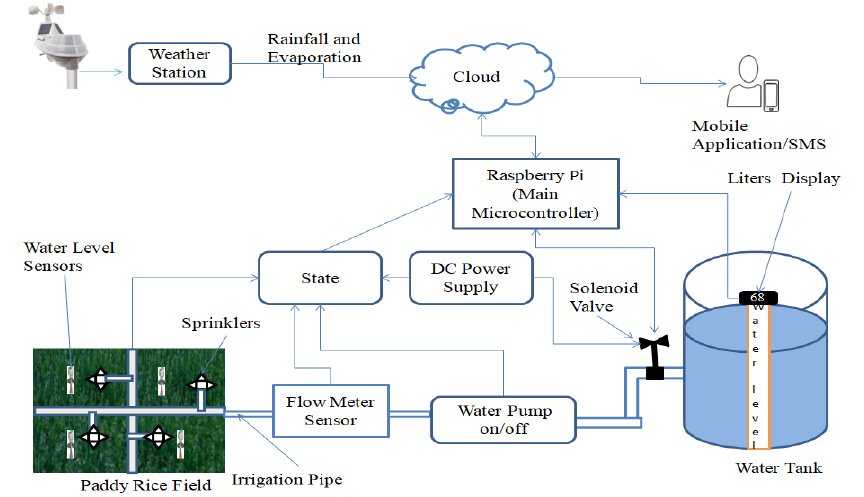
Figure 4. System architecture that shows the complete irrigation